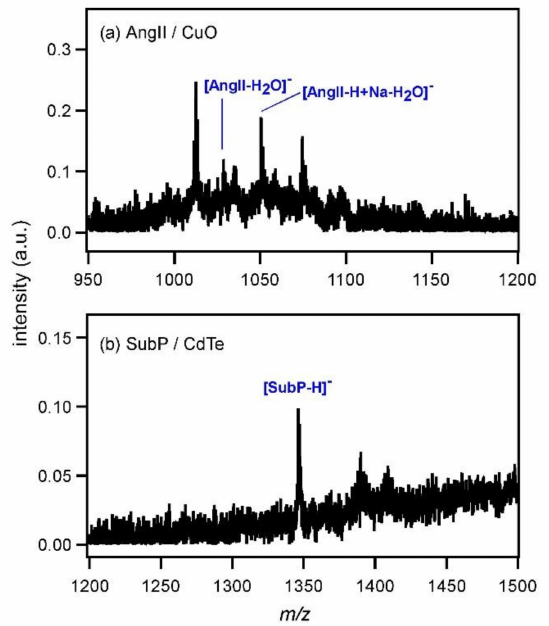
Figure 6. ( a ) Mass spectrum of angiotensin II (AngII) measured with CuO; ( b ) mass spectrum of substance P (SubP) measured with